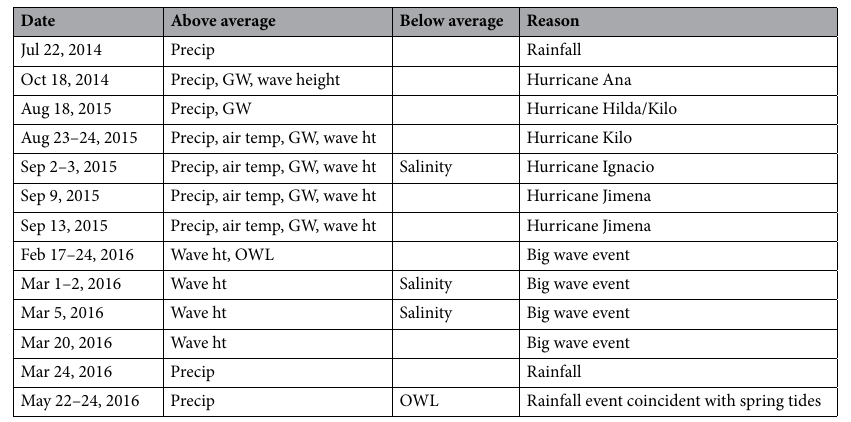
Table 1. Multivariate outlier events by date, variables above or below average during those dates, and associated cause. Three types of events were identified from the record: heavy rainfall, tropical storms, and big wave